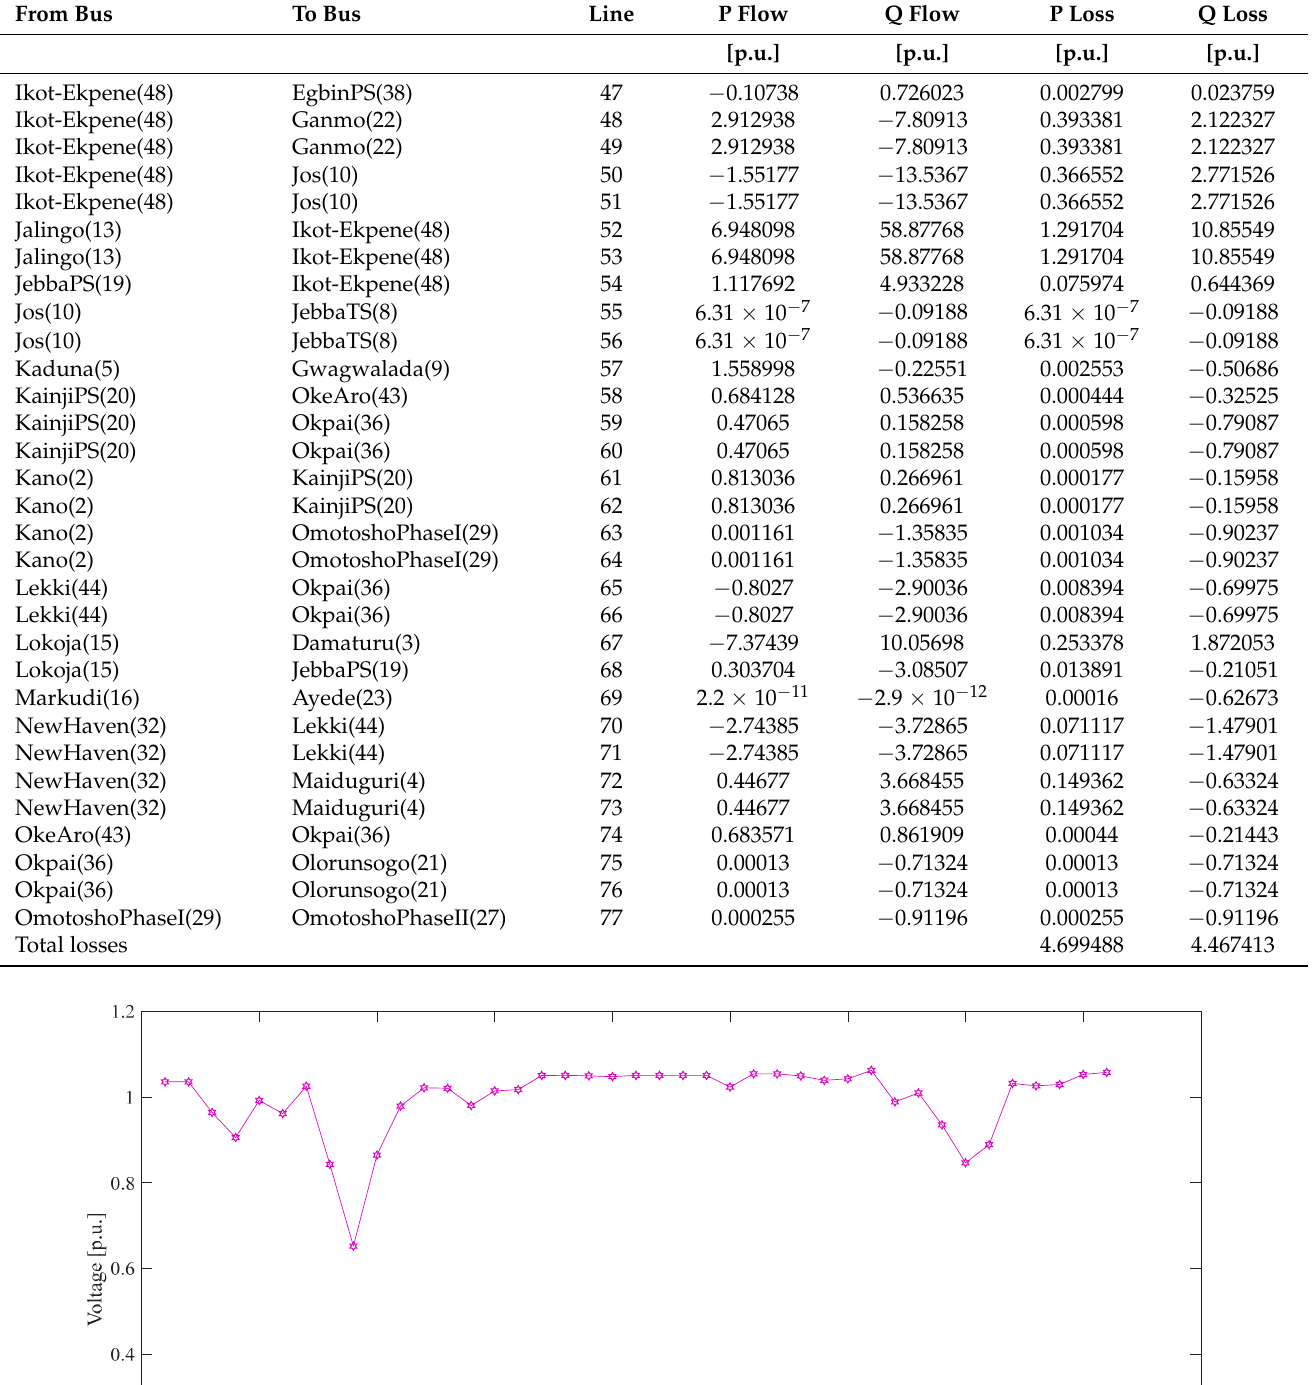
Figure 5. Real power output of the uncompensated Nigerian 41 bus transmission network. R ea l P o w e r P G - P L [ p . u . ]